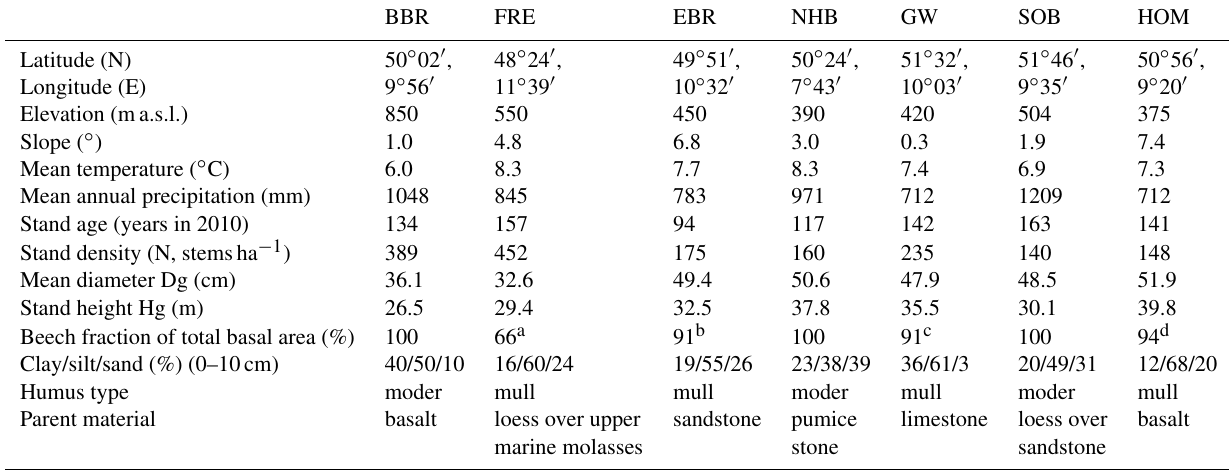
Table 1. Site and stand characteristics of seven European beech ( Fagus sylvatica L.) forest ecosystems (reference year 2010). Site abbrevia- tions are explained in the text.